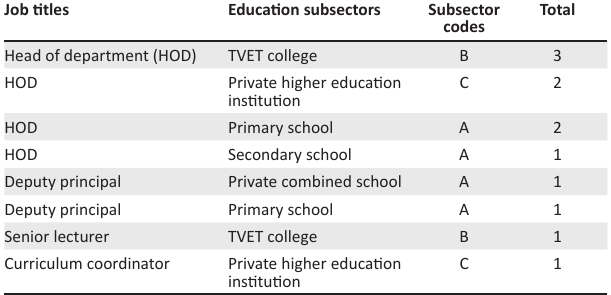
TABLE 2: Research participants’ job titles and relevant education